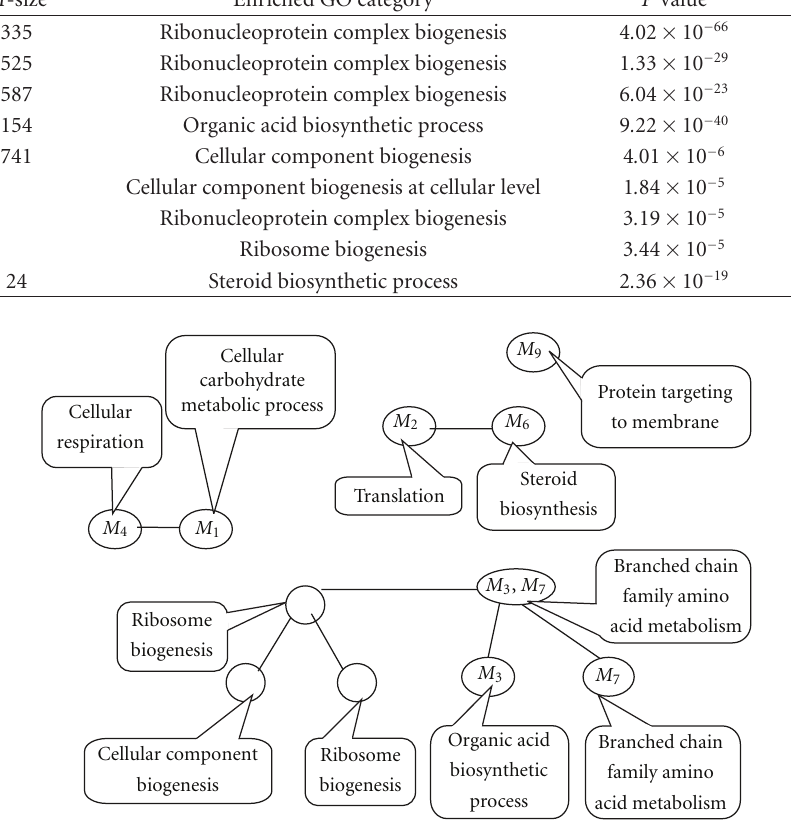
Figure 6: Tree map of the enriched GO categories in yeast gene coexpression